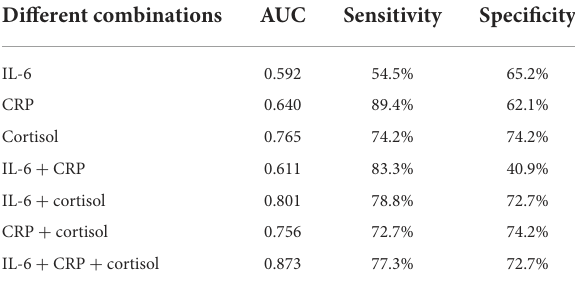
TABLE 4 AUCs of differential combination of IL-6, CRP and cortisol for discriminating MDD and HC. Different